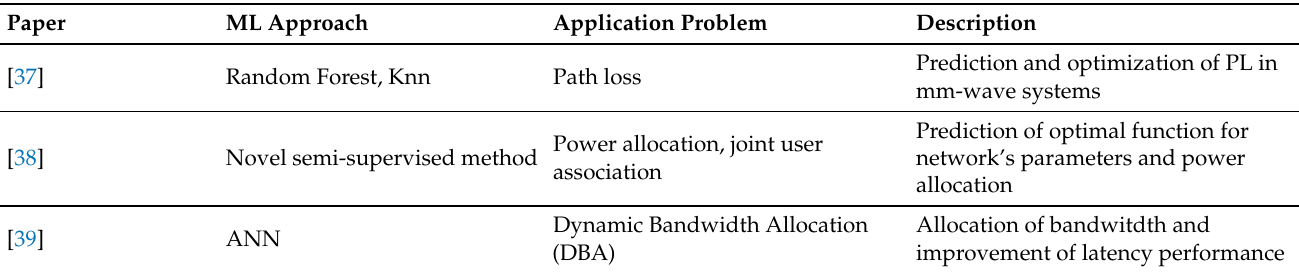
Table 5. Supervised ML models in B5G/6G optimization